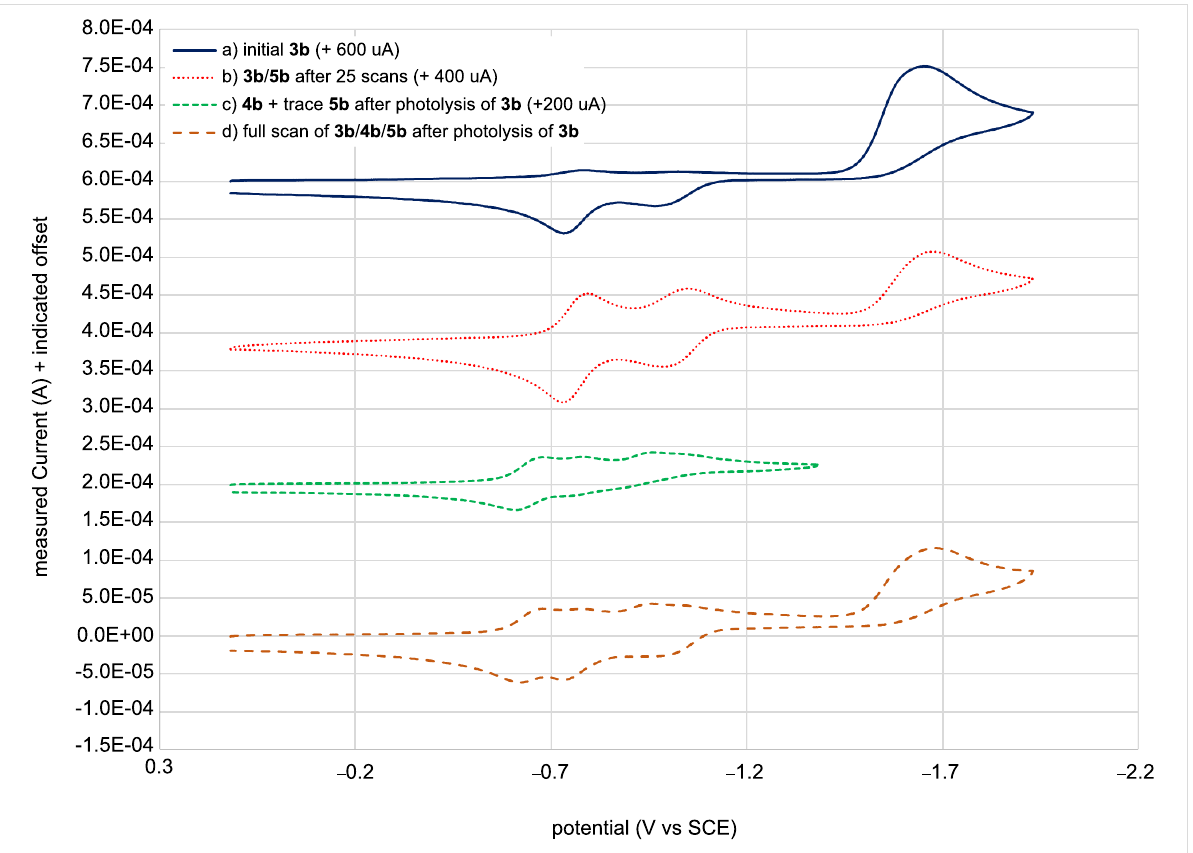
Figure 3: Cyclic voltammograms of a) 3b (with trace 5b ) before irradiation or electrolysis (solid blue), b) 3b + 5b after 25 scans (dotted red) showing the growth of the two 5b reduction peaks, c) 3b (with trace 5b ) after photolyzing but without reducing 3b in the electrolysis (dashed green) which shows the two initial eLW 5b and two new pLW 4b reversible redox waves observed, and d) 3b + 4b + 5b observed by scanning the full potential window after the photolysis of 3b (dashed orange).